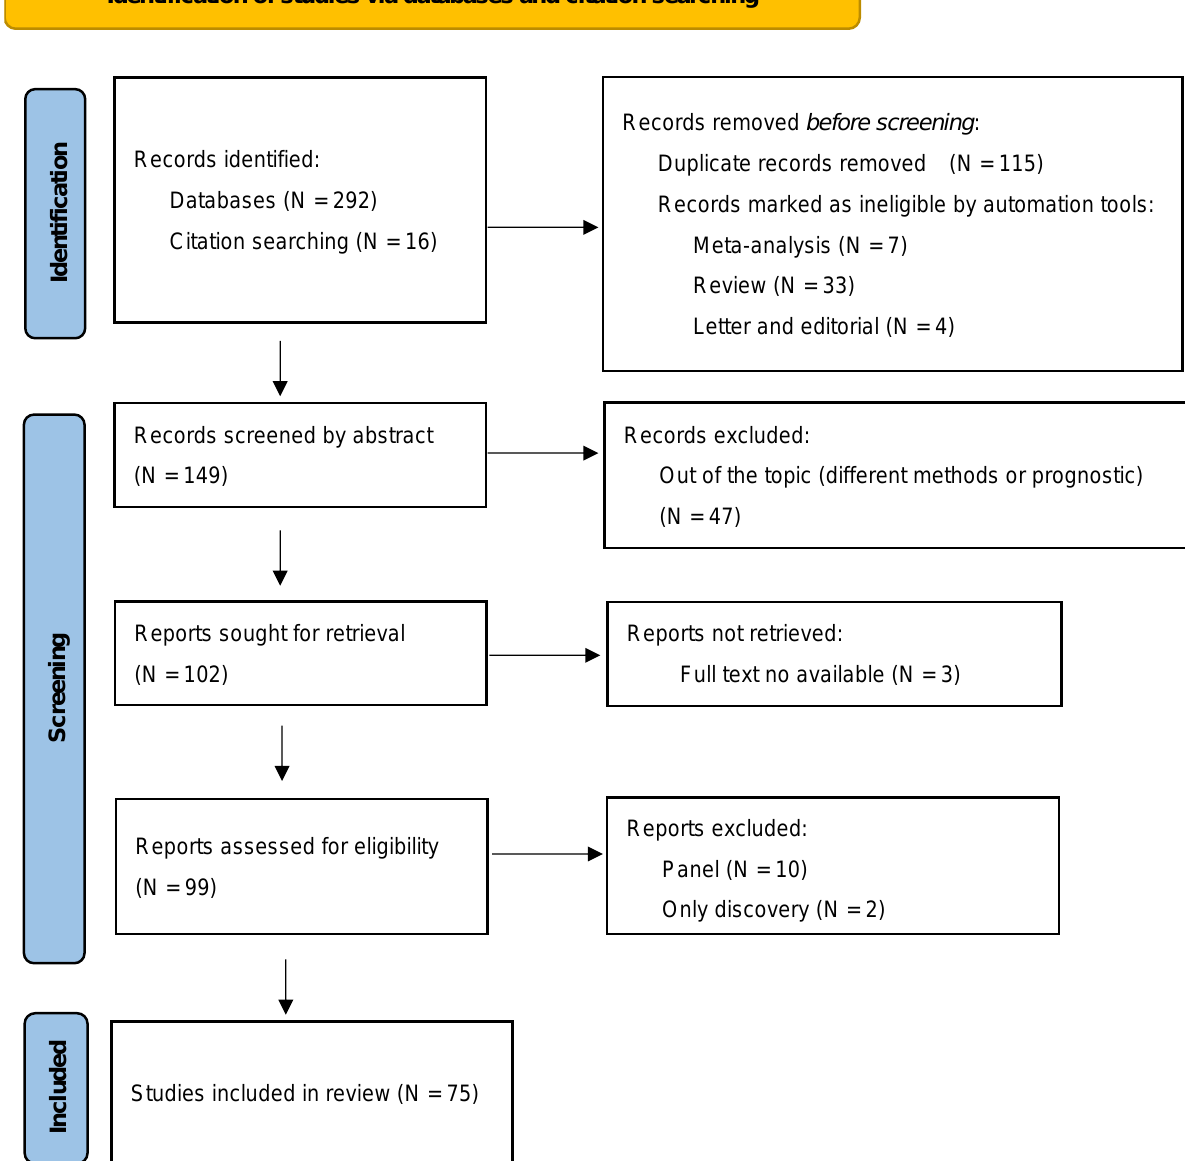
Figure 1. The flow chart of identification, screening, and eligibility of the included studies [8].